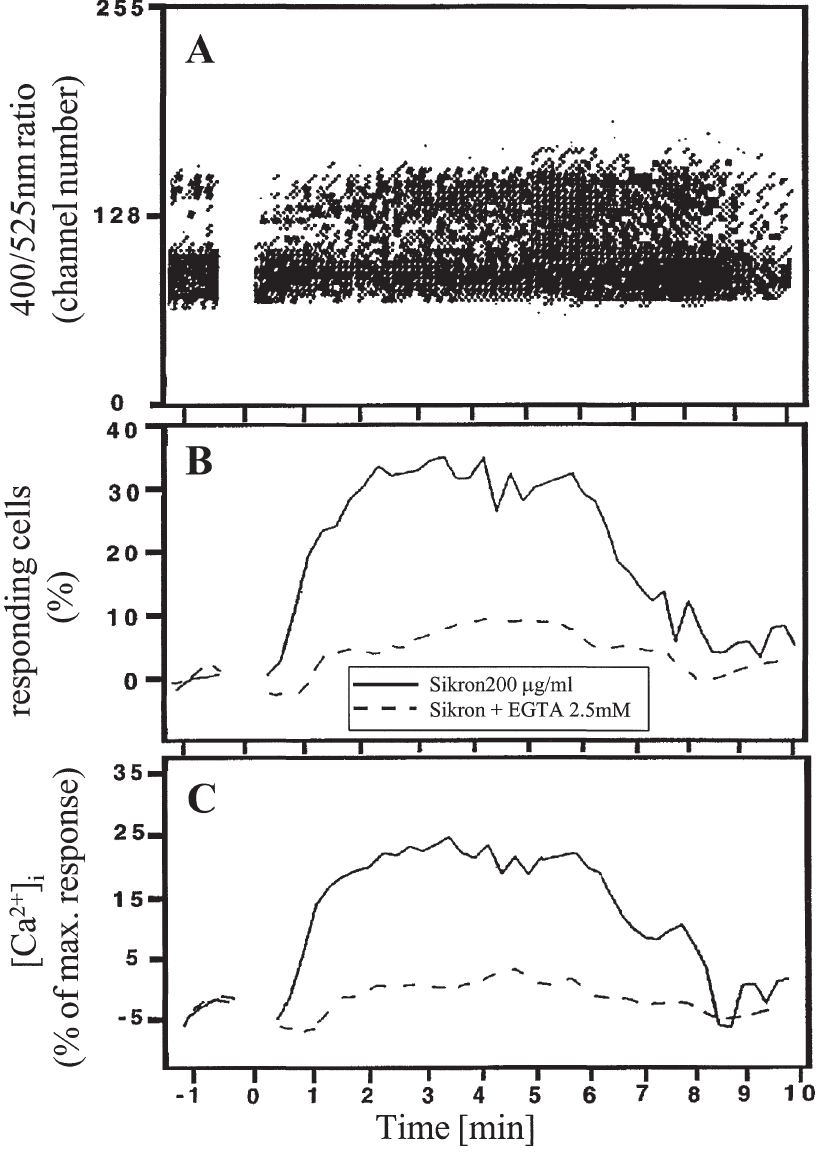
Fig. 1. Kinetics of [Ca 2 + ] i of Indo-1-stained BAM after stimulation with quartz dust Sikron F 600. Baseline fluorescence was monitored for 1 min. Cells were then stimulated by the addition of a 100 × concentrated quartz suspension ( t = 0 min) and subsequently measured for the indicated time. In (A) data are plotted as the 400/525 nm fluorescence emission ratio of single cells in a bivariate array vs. time. In (B) the percentage of responders and in (C) the percentage of maximal response is plotted vs. time. Hatched lines in (B) and (C) show the kinetics of cells from the same preparation in the presence of 2.5 mM